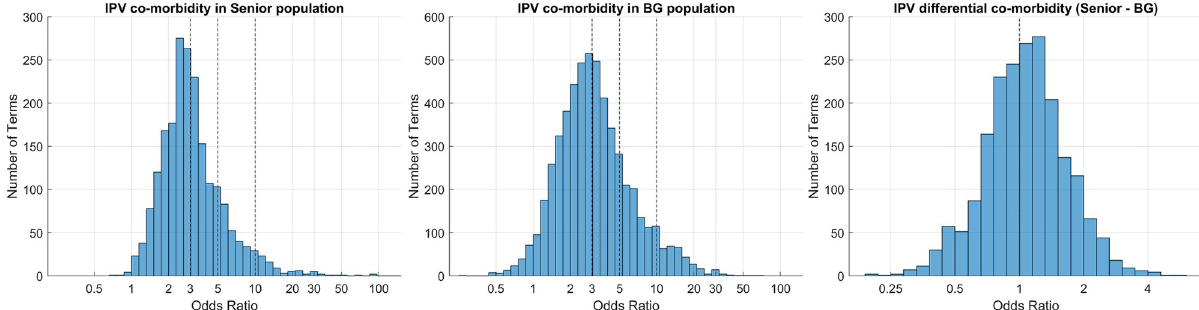
Fig 2. The distributions of co-morbidity and differential co-morbidity scores in Senior and Background (BG) populations. (Left & Middle panels) The distribution of the raw co-morbidity scores (i.e., odds ratios) for all terms in Senior and Background populations. The geometric mean of the co- morbidity scores across all terms is used to determine the null level accounting for the detection bias (OR � 3 is the mean across all terms as opposed to the OR = 1 natural level). The null hypothesis thresholds to determine Minor/Moderate/High co-morbidity terms are marked on the histograms (OR = 3/5/10). (Right panel) The distribution of the differential co-morbidity scores for all terms. Since there is not a notable shift in the histogram, OR = 1 is considered as the null level for differential co-morbidity. OR: Odds